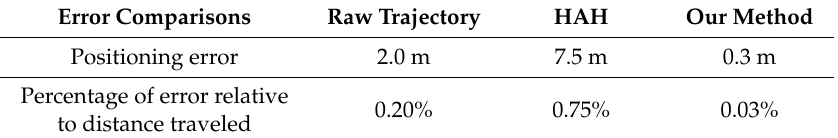
Figure 15. Trajectories for our method, the HAH method and raw trajectory. Our method has better accuracy than HAH and raw trajectory.